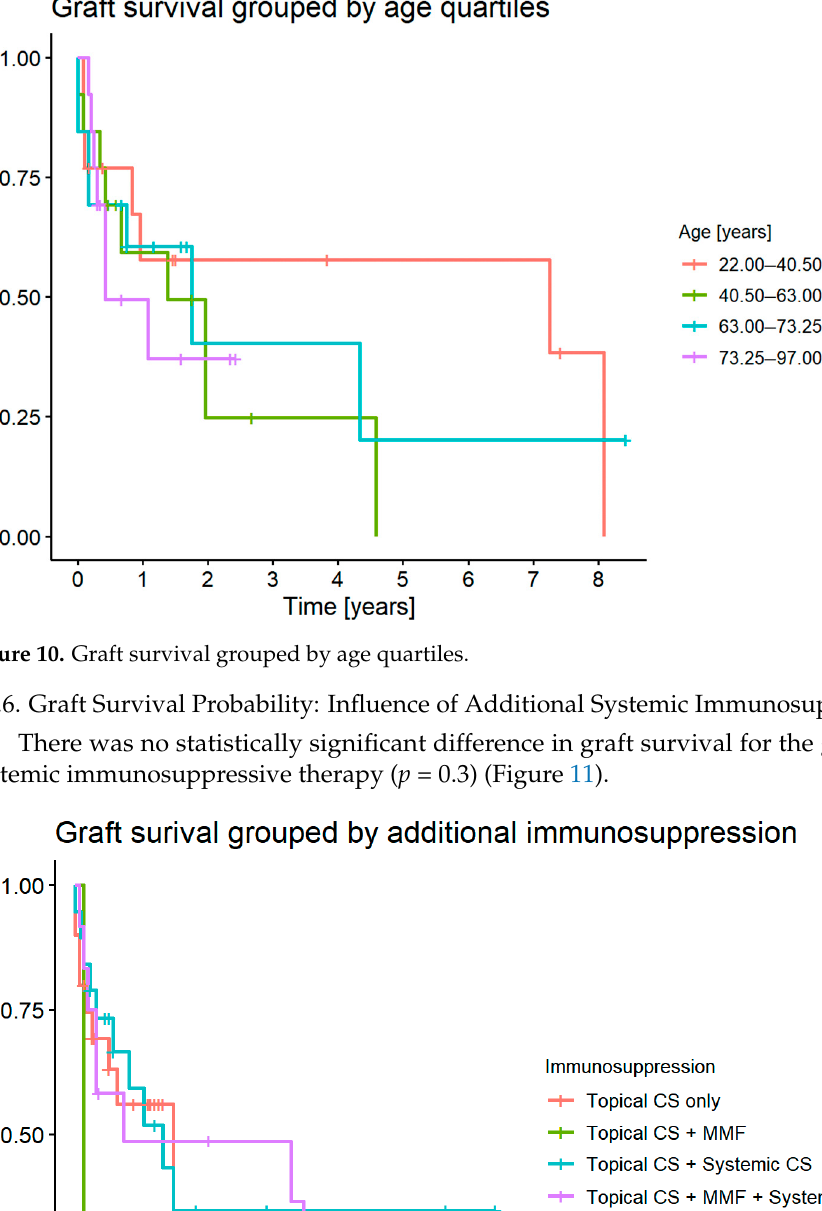
Figure 9. Survival probability and the history of previous surgical procedures.